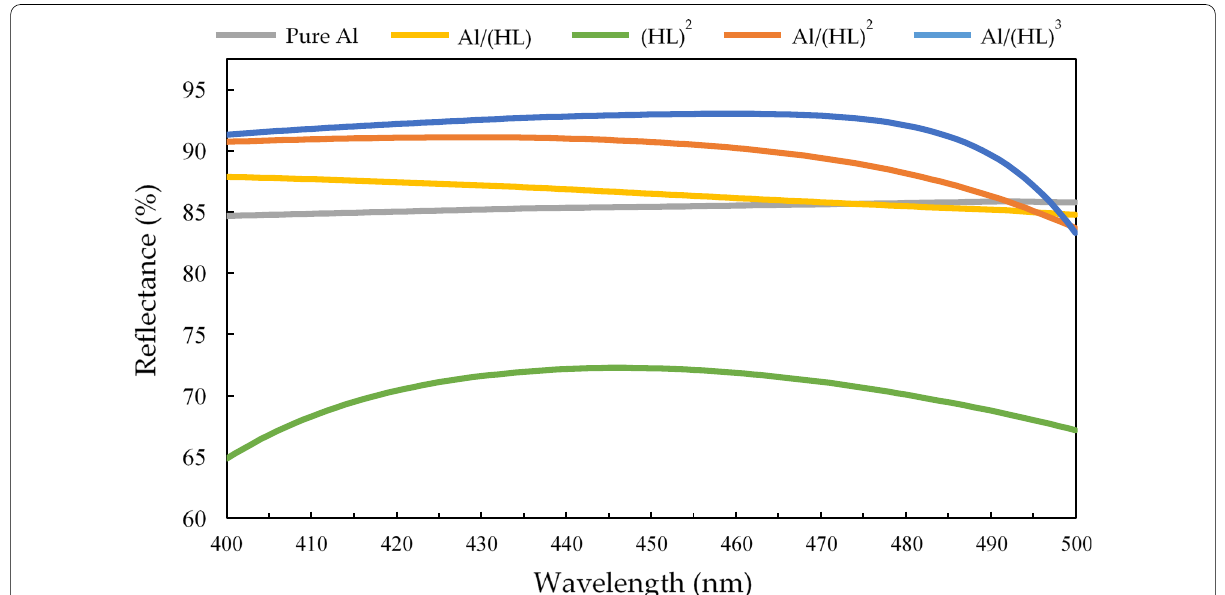
Fig. 3 Reflectance of pure Al, Al/(HL), (HL) 2 , Al/(HL) 2 , and Al/(HL) 3 was simulated at wavelengths of 400–500 nm